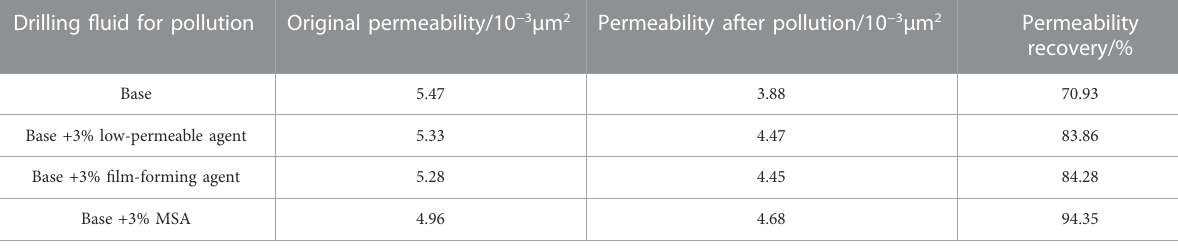
TABLE 9 Permeability recovery of the low-permeable rock core after polluting with different drilling fl uids. Drilling fl uid for pollution